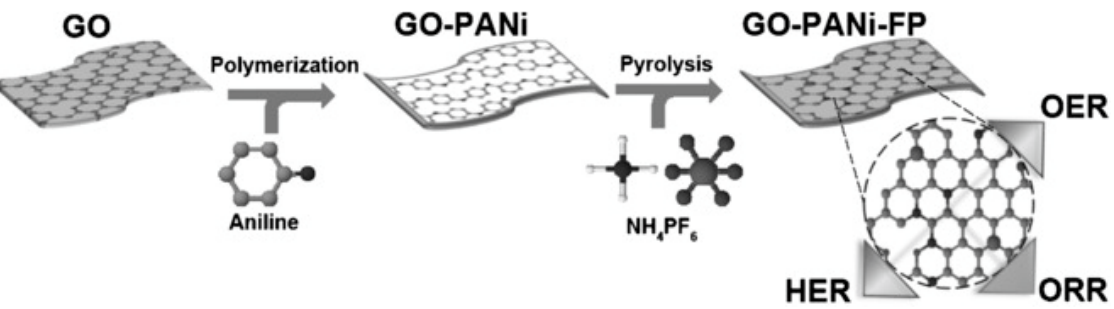
Figure 4. Preparation method of GO-PANi-FP tri-functional electrocatalyst material. Reprinted with permission from Ref. [72]. Copyright 2016 John Wiley and Sons.